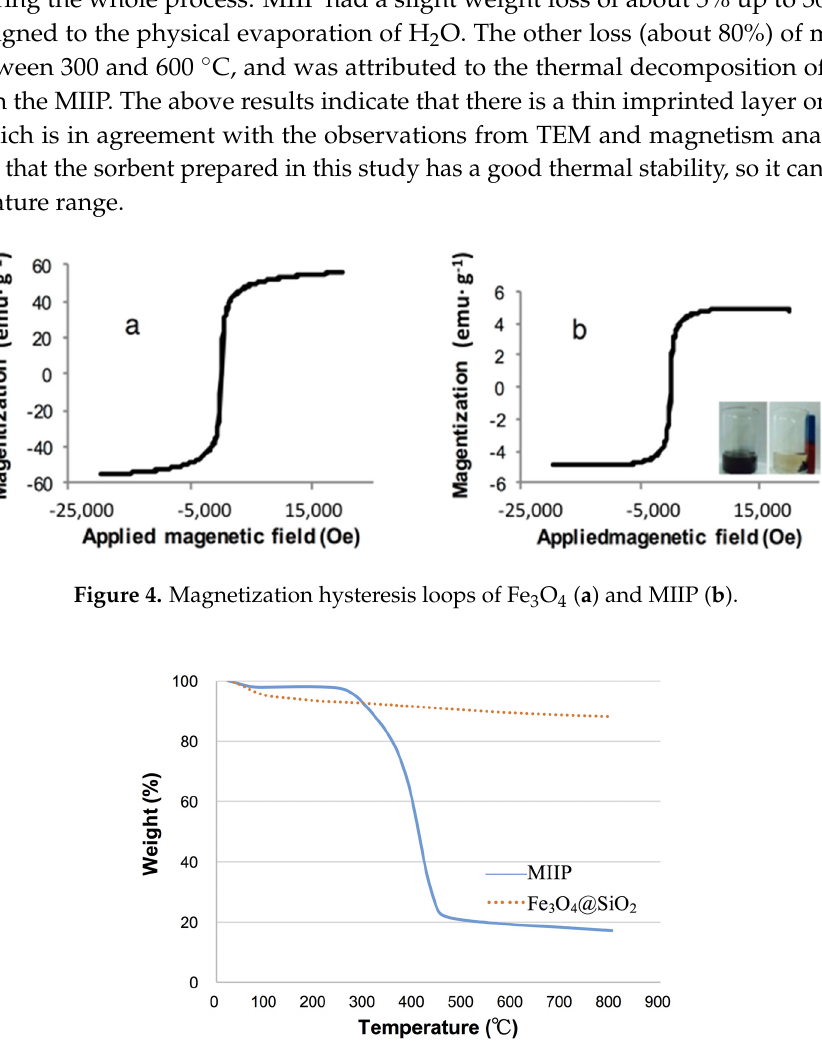
Figure 5. Thermal gravimetric analysis (TGA) curves of Fe 3 O 4 @SiO 2 and MIIP.